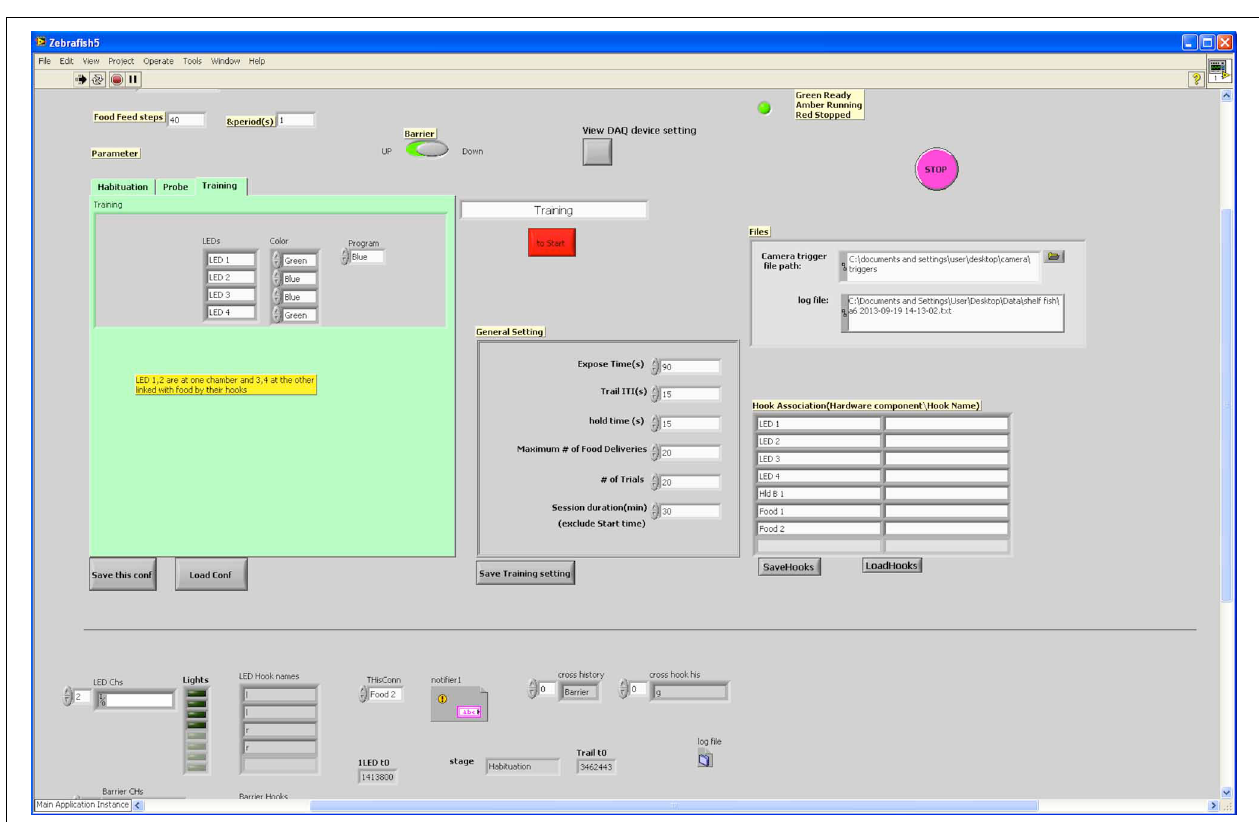
FIGURE 4 | User interface for LabView program. The user-interface for the LabView programme was designed to be flexible according to user requirements. We were able to change testing parameters easily prior to each